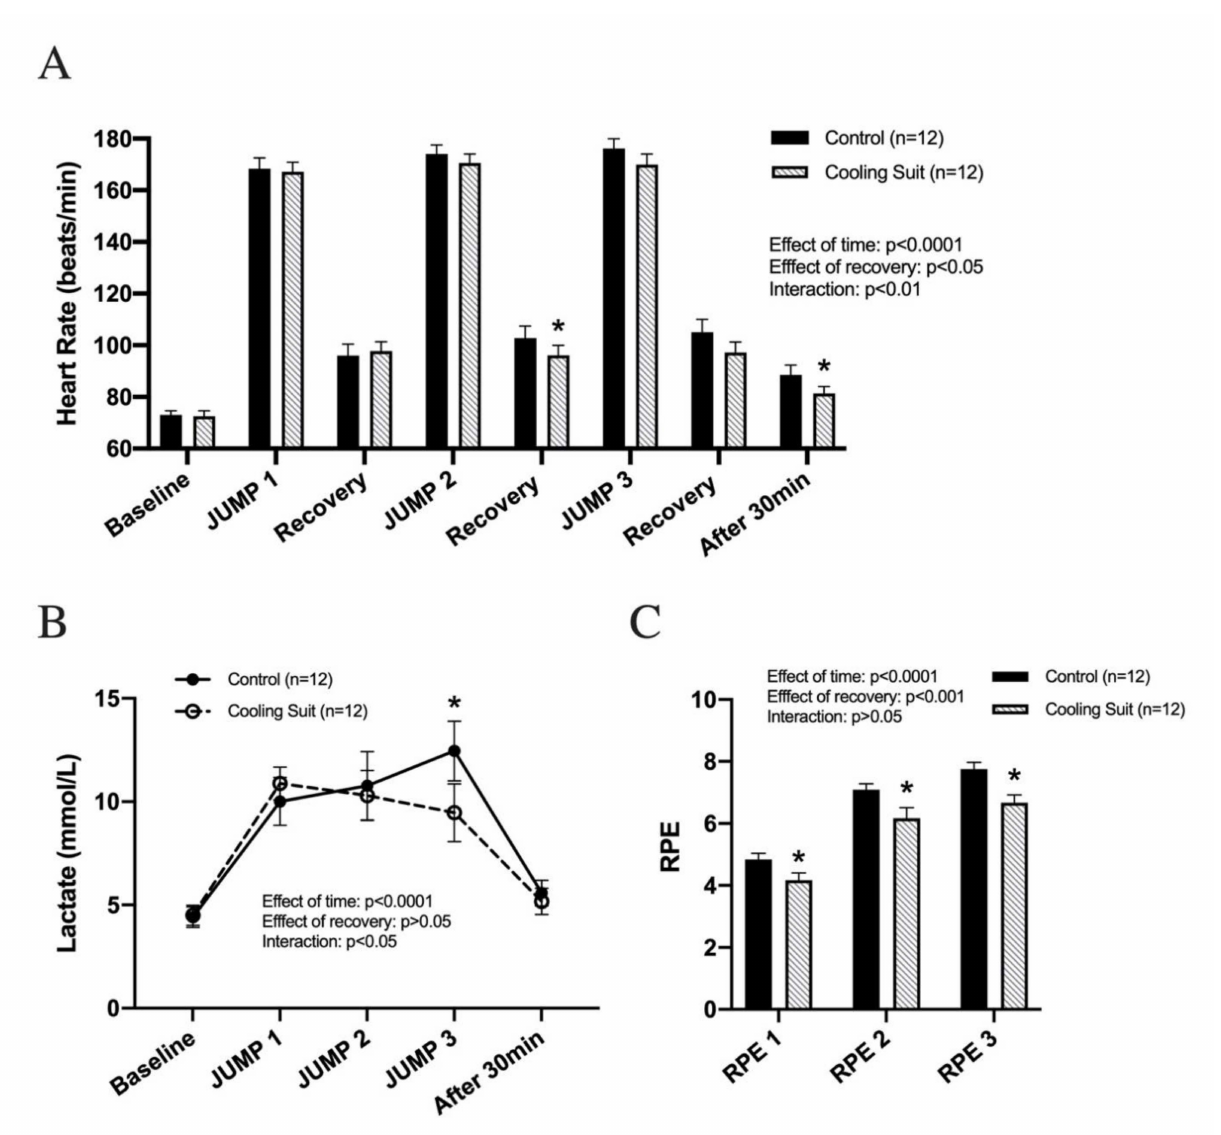
Figure 3. Changes in heart rate ( A ), lactate ( B ), and RPE ( C ). Each set ( A – C ) consists of 30 consecutive vertical jumps. * p < 0.05 vs. control. Data are presented as the mean ±